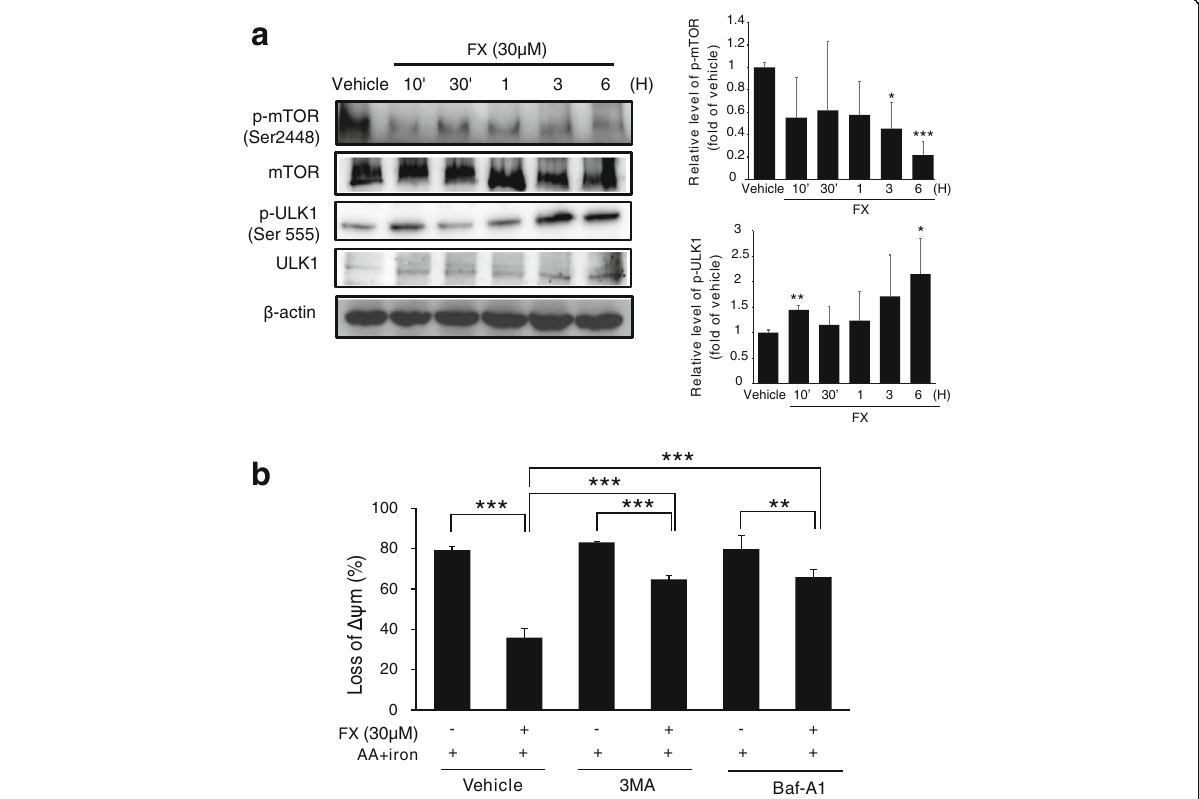
Fig. 5 The role of AMPK activation by FX in autophagy induction. ( a ) Western blot analysis for the phosphorylated level of mTOR (Ser2448) and ULK1 (Ser555) in HepG2 cells treated with 30 μ M FX for indicated time period. Results represent the mean ± S.D. for four separate experiments. * p <0.05; ** p <0.01; *** p <0.001. ( b ) The effect of FX to restore ΔΨ m was revered by 3-MA and Baf-A1. After 3-MA and Baf-A1 treatment (5 μ M for 1 h, respectively), cells were incubated with FX for 1 h, being followed by the addition of AA (for 12 h)+iron (1 h). Data represent the mean±S.D. for three replicates. ** p <0.01; *** p